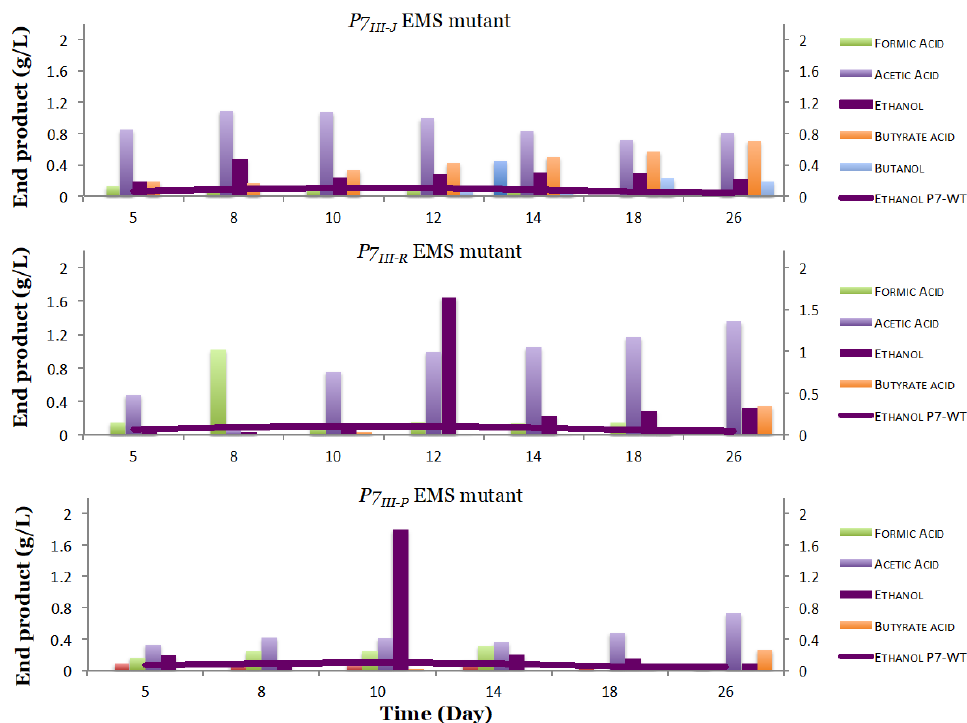
Figure 4. End products identified for the mutagenized Clostridium carboxidivorans P7-EMS mutants. Three out of 55 P7-EMS mutants presented di ff erent products and product profiles when compared to the wild type P7. The three mutants ( P7 III-J , P7 III-R , and P7 III-P ) showed increased ethanol production, CO 2 is provided as the only source of carbon. The purple line represents ethanol production of the P7 wild type. Microorganisms 2020 , 8 , x FOR PEER REVIEW